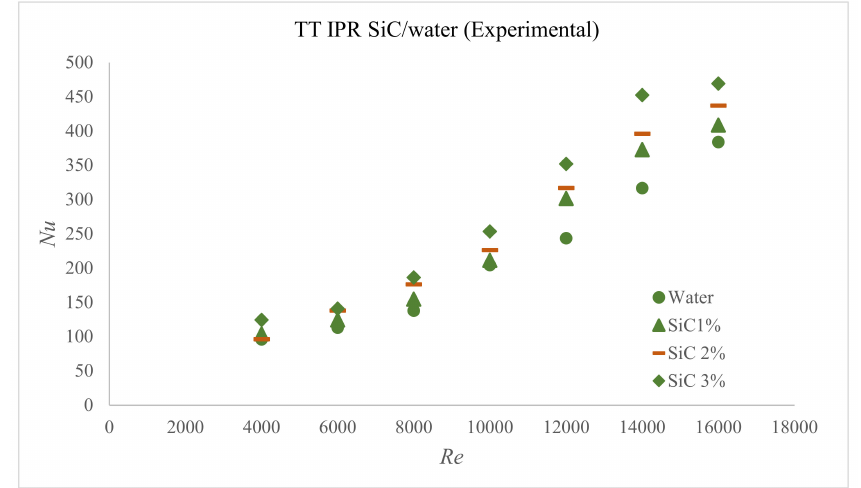
Figure 25. E ff ect of the nanofluid volume fraction ϕ on Nu (Experimental).